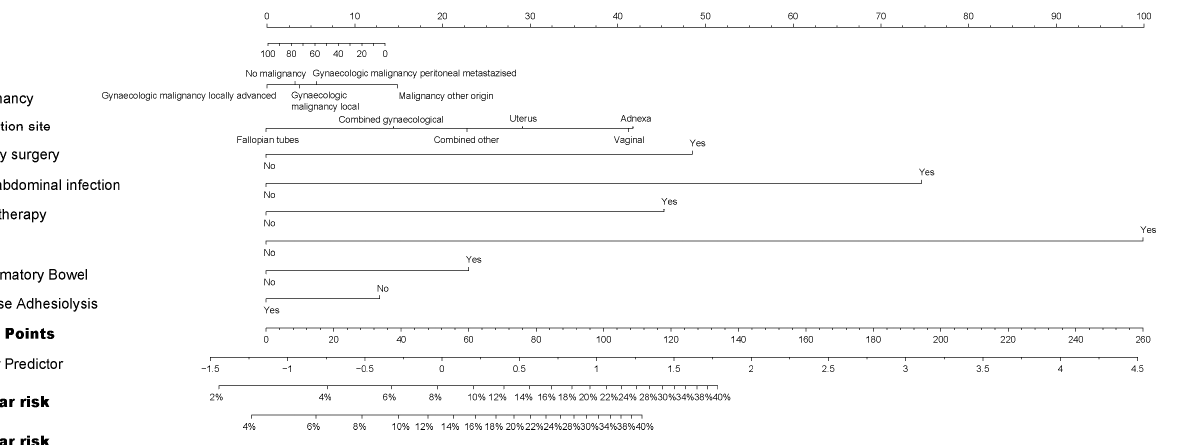
Figure 4. Nomogram to predict reoperation after initial gynecological surgery. IBD = inflammatory bowel disease.